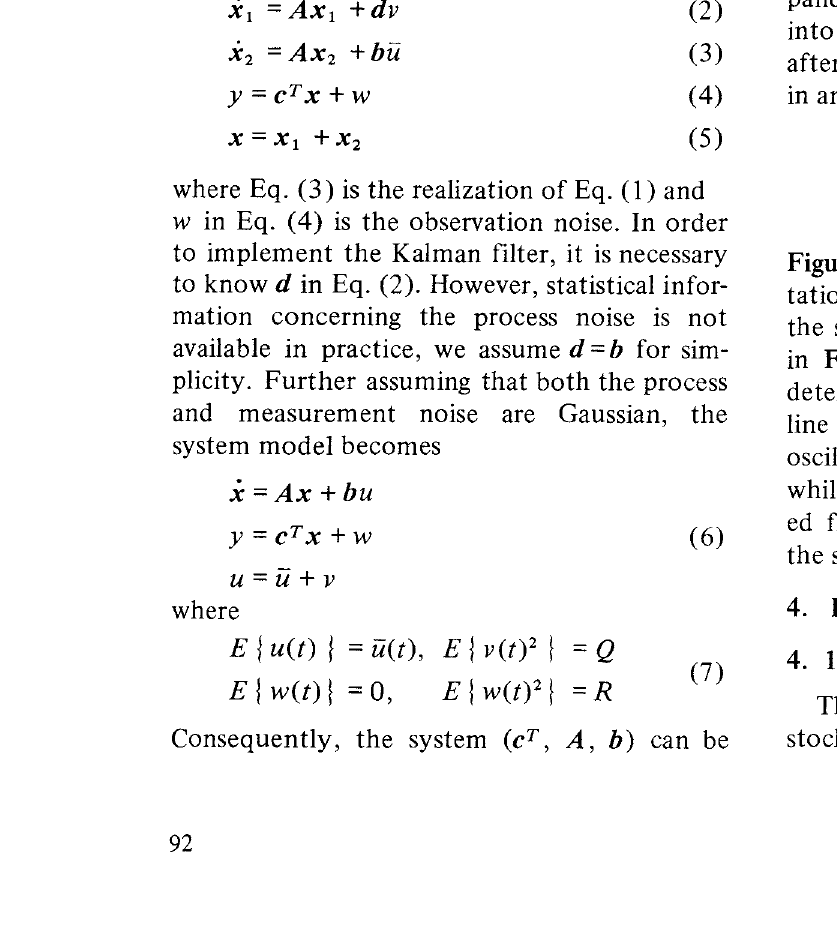
Fig. 5 Comparison of actual step response with one calculated by model (the solid line indicates the deterministic part of Eq. (8), and the dotted line Eq.